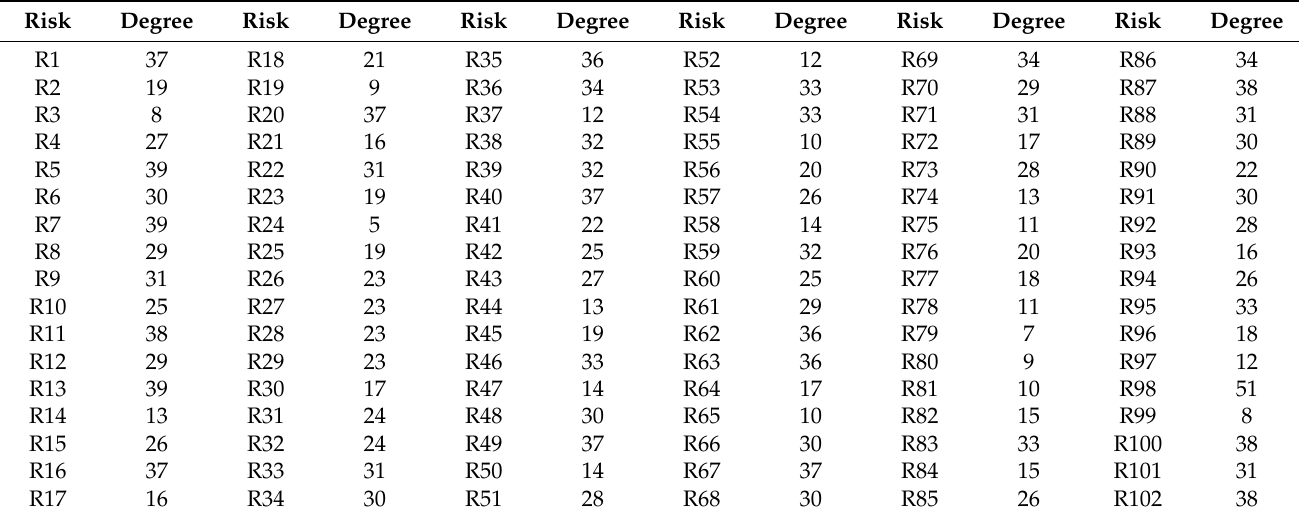
Table 3. Importance of the identified risks in terms of the degree of centrality.